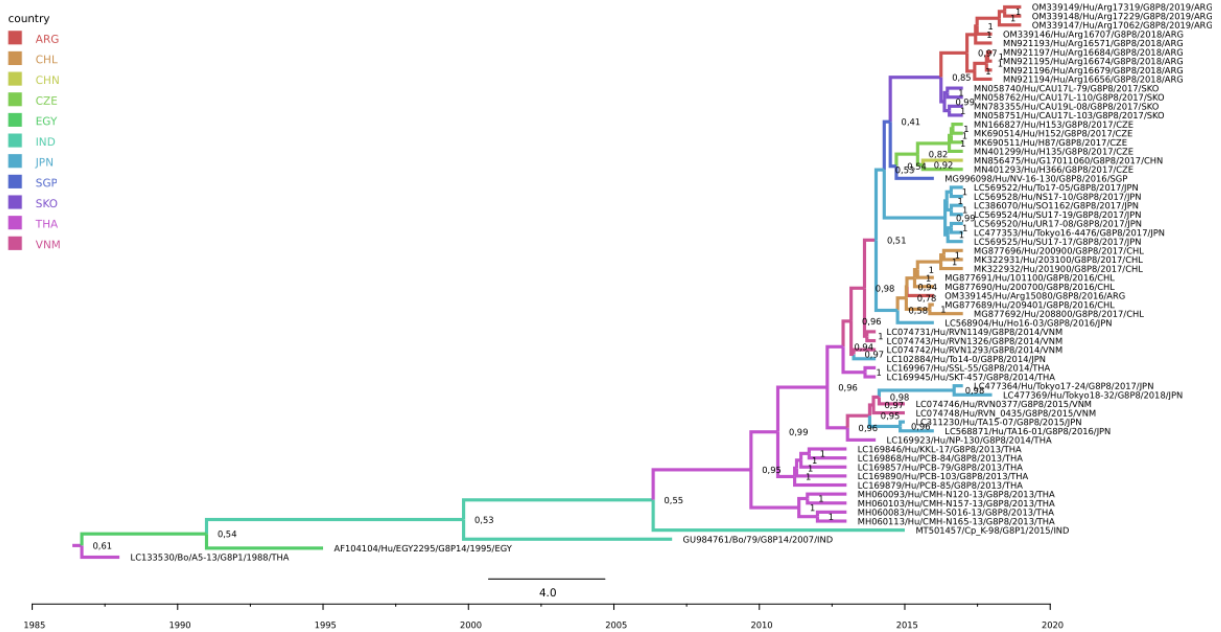
Figure 1. Maximum Clade Credibility Tree (MCCT) of G8-lineage IV strains. Branches are color-coded according to their location’s discrete state (ARG: Argentina, CHL: Chile, CHN: China, CZE: Czech Republic, EGY: Egypt, IND: India, JPN: Japan, SGP: Singapore, SKO: South Korea, THA: Thailand, VNM: Vietnam). Timescale is indicated below the tree. Posterior probability values of the ancestral state are shown in each branch. Additionally, clade posterior probability values for groups with Argentinean sequences are shown at nodes in parentheses.